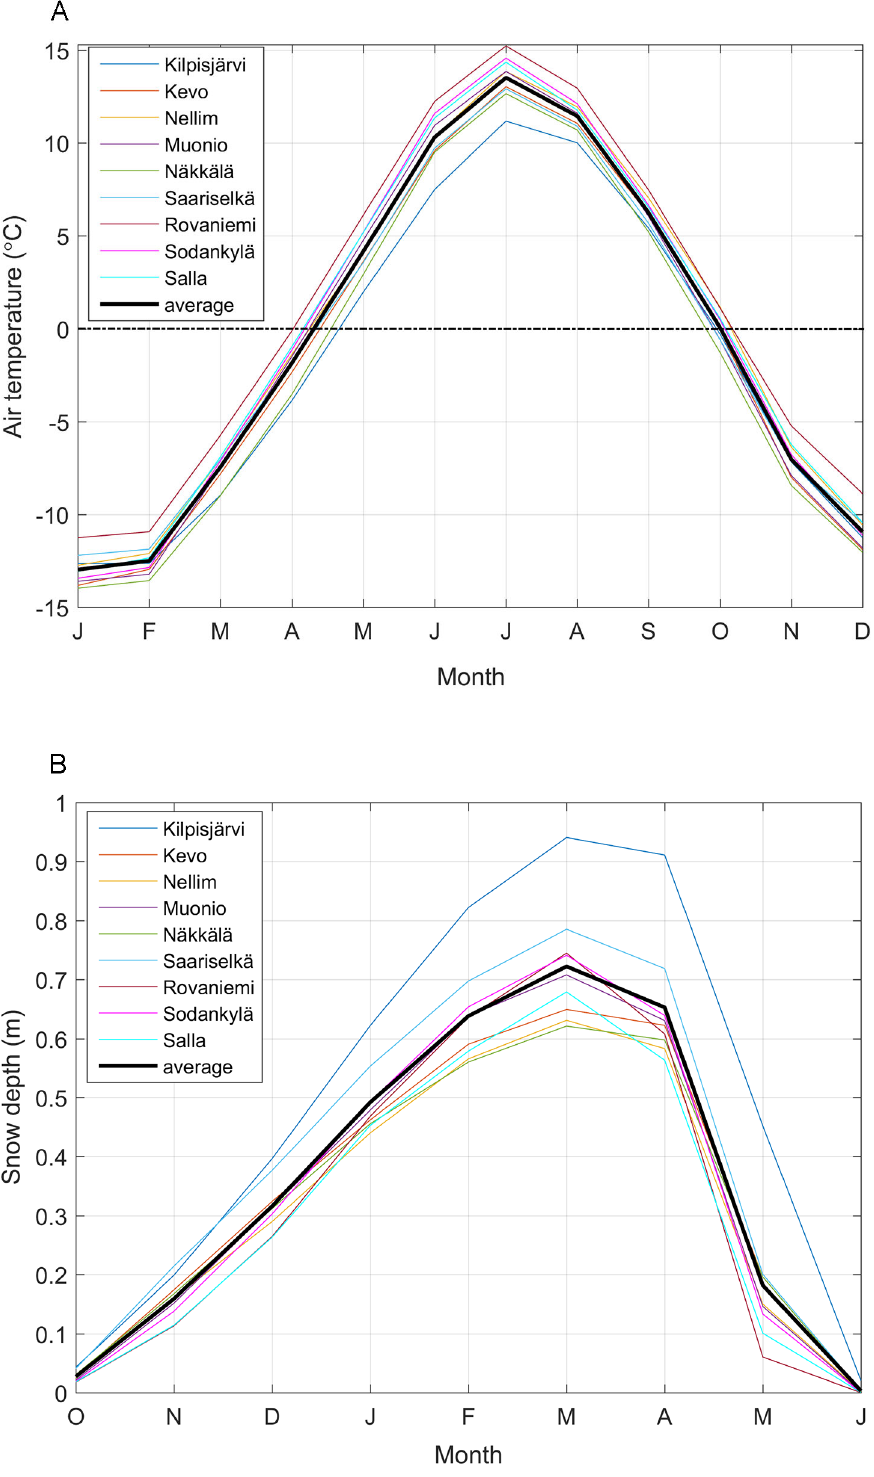
Fig. 2. Seasonal variations in air temperature (A), maximum snow depth (B) and precipitation (C) in Finnish Lapland averaged over 30 years